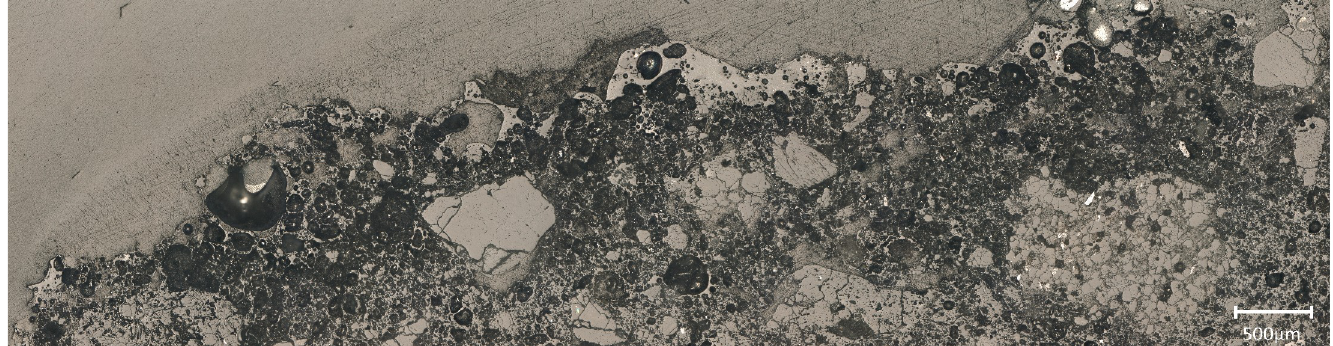
Fig 6. PPL micrograph of E13 with a very thin slag layer. Note the great interaction between the ceramic paste and the slag layer and the development of bloating pores. (Scale = 500 μ m).